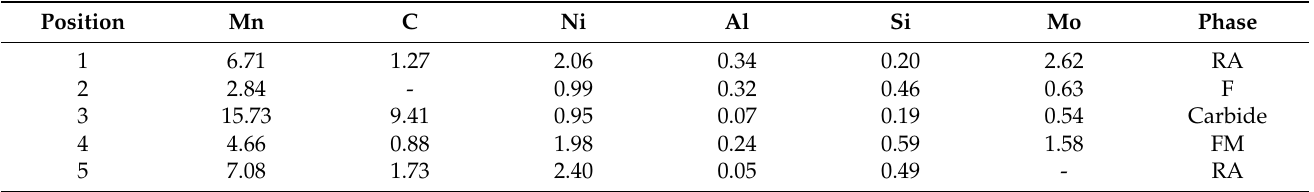
Figure 8. STEM images of the Def-A650 specimen. ( a ) Lath and equiaxed structure of martensite and RA phases, ( b ) two morphologies of retained austenite as films between the martensite laths, and some globular grains along with carbides on lath boundaries, ( c ) strings of large carbides on lath boundaries and spherical and rod-shaped carbides inside the TM laths. Table 1. Chemical composition of the areas marked by numbers in Figure 9c measured by